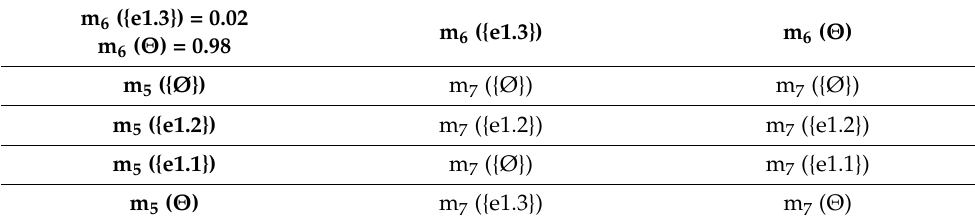
Table 5. Observation e1.3.